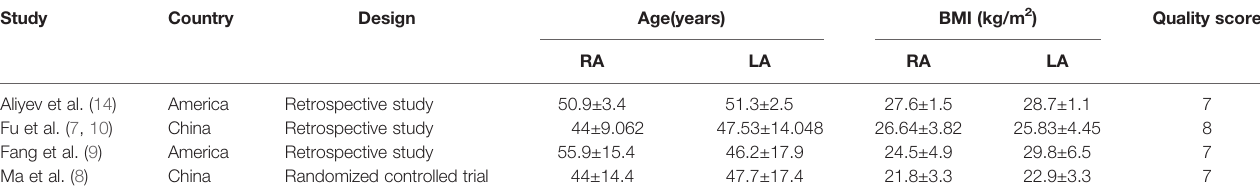
TABLE 1 | General characteristics and quality assessment of enrolled